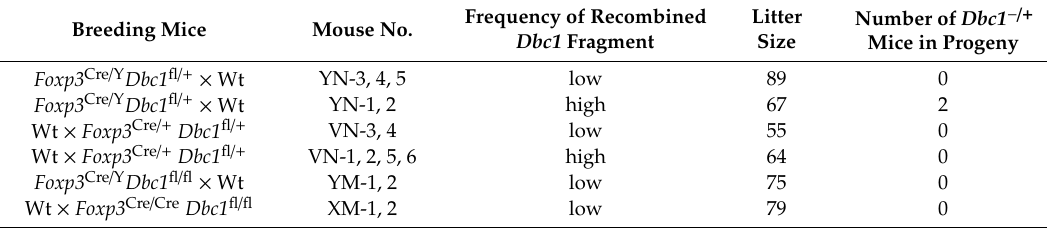
Table 1. Frequency of mice with deleted Dbc1 allele in the progeny of di ff erent breeding pairs. Breeding Mice